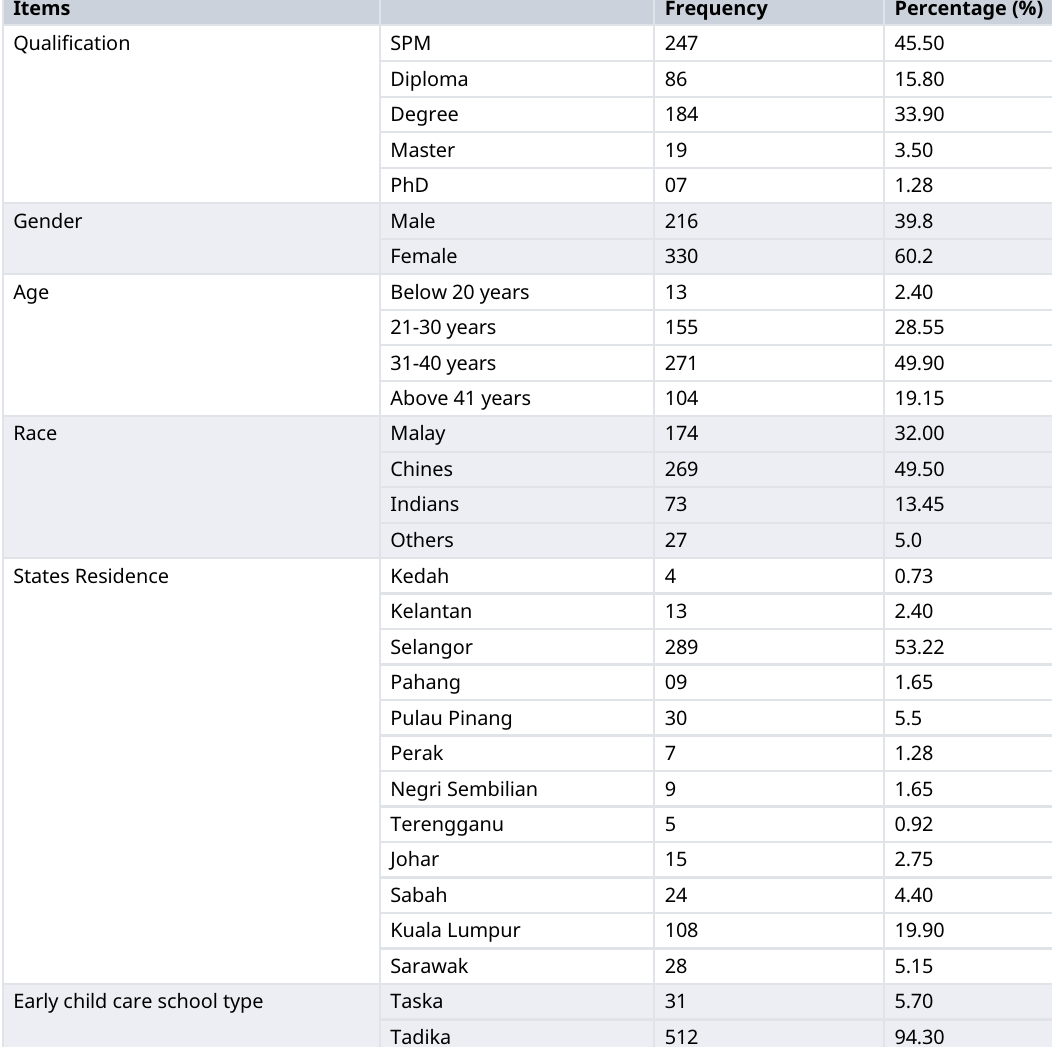
Table 1. Participants demographic information (N=543; SPM: Malaysian Certificate of Education).